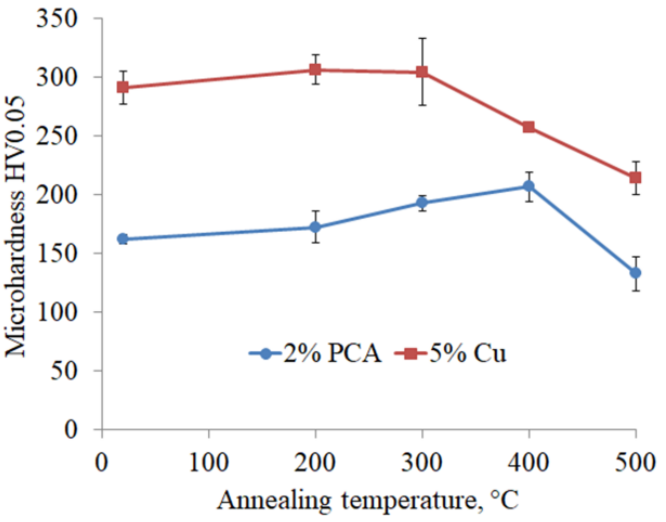
Figure 3. The effect of annealing temperature on the microhardness of cold-pressed powders.